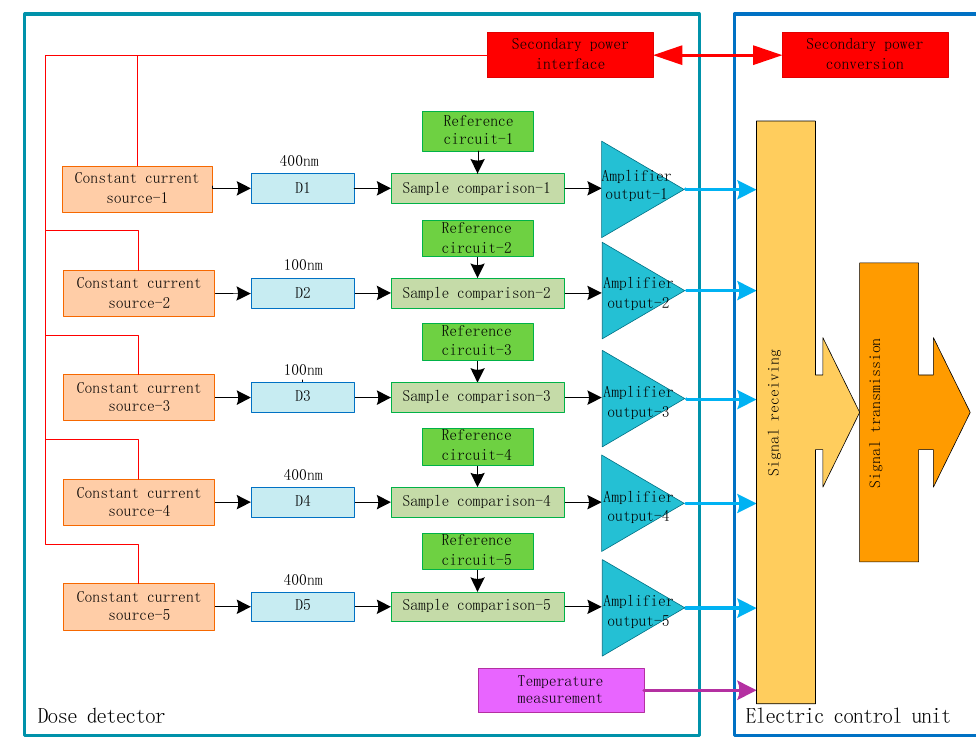
Figure 3. Electronic principle diagram of the radiation dose detector.